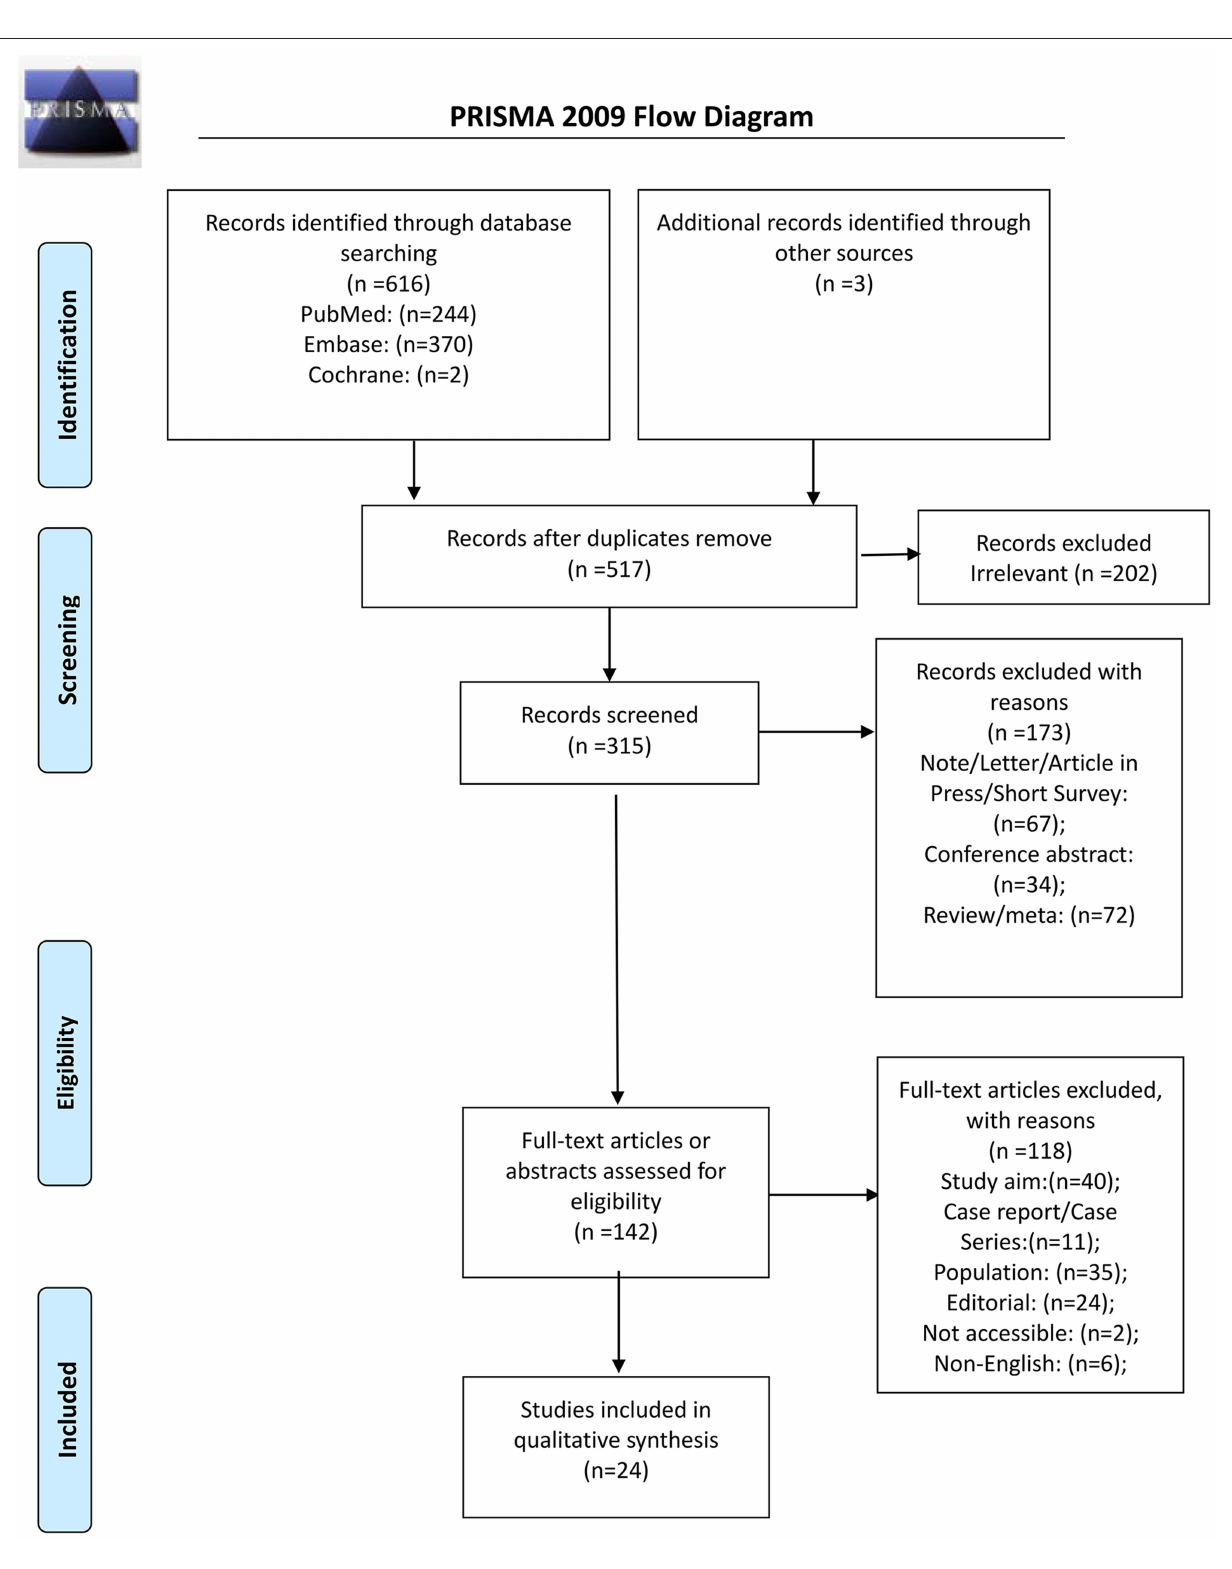
FIGURE 1 | Flow diagram of study